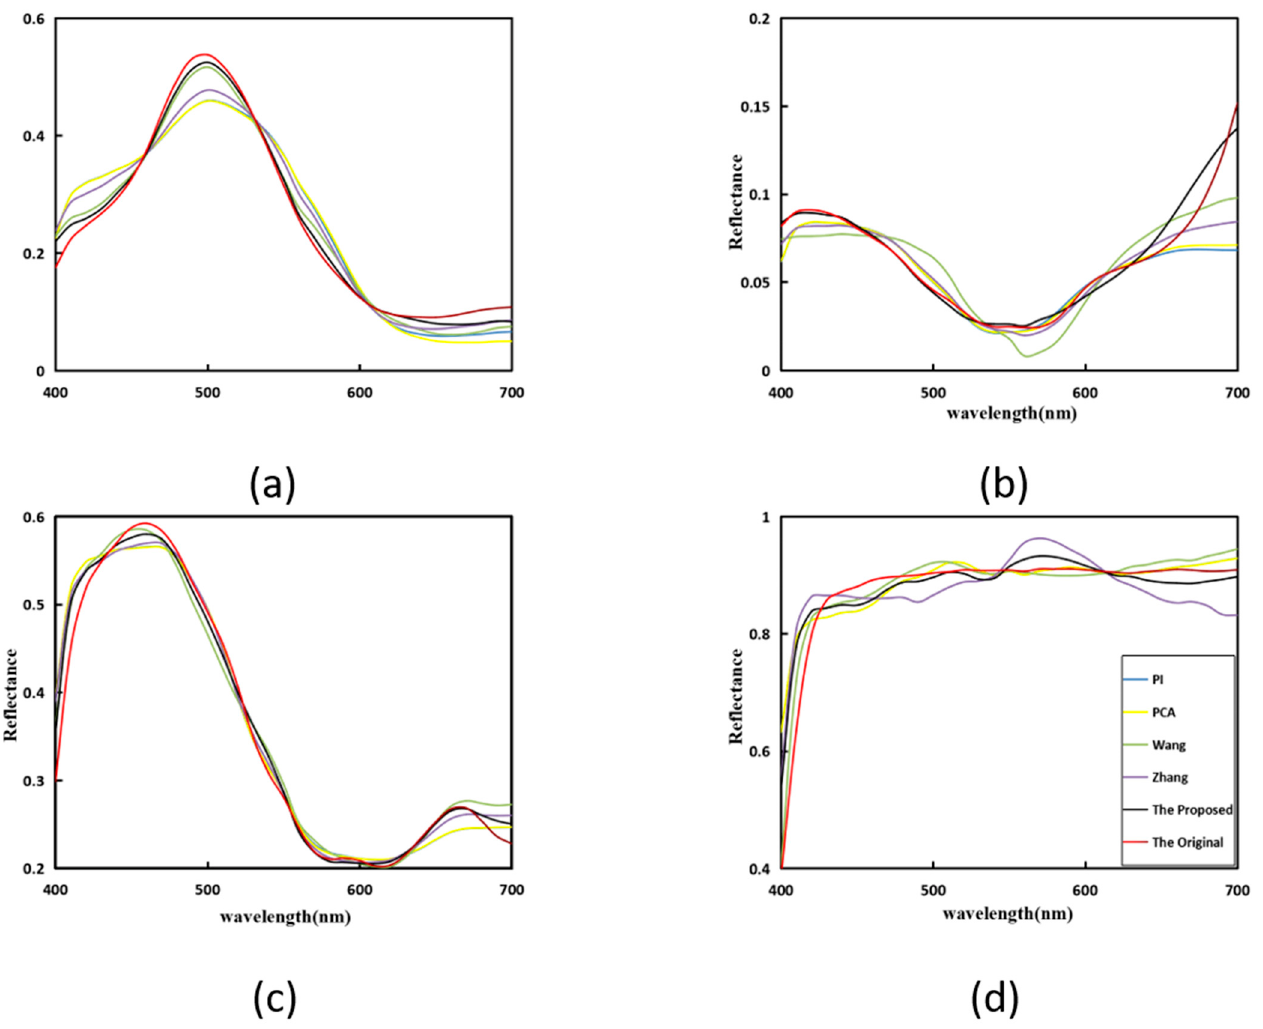
Figure 7. Spectral reflectance recovery results from our proposed and existing methods with four randomly selected samples (Wang [37], Zhang [32]): ( a ) 18, ( b ) 22, ( c ) 92, and ( d ) 40.